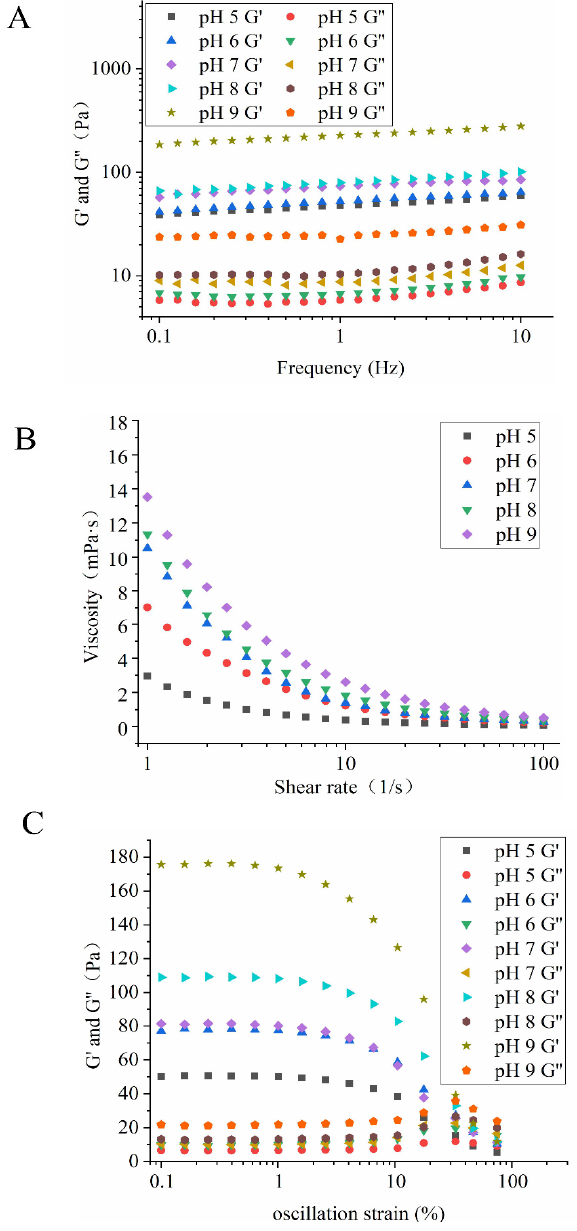
Figure 9. Rheological behavior of HIPEs stabilized by 3.0 wt% EYGs at NaCl ionic strength of 0.3 M with different pH. The φ is 0.8. Storage (G ′ ) and loss (G ″ ) moduli of the HIPEs as a function of frequency ( A ). Apparent viscosity of the HIPEs as a function of shear rate ( B ). G ′ and G ′′ of the HIPEs as a function of oscillation strain ( C ).